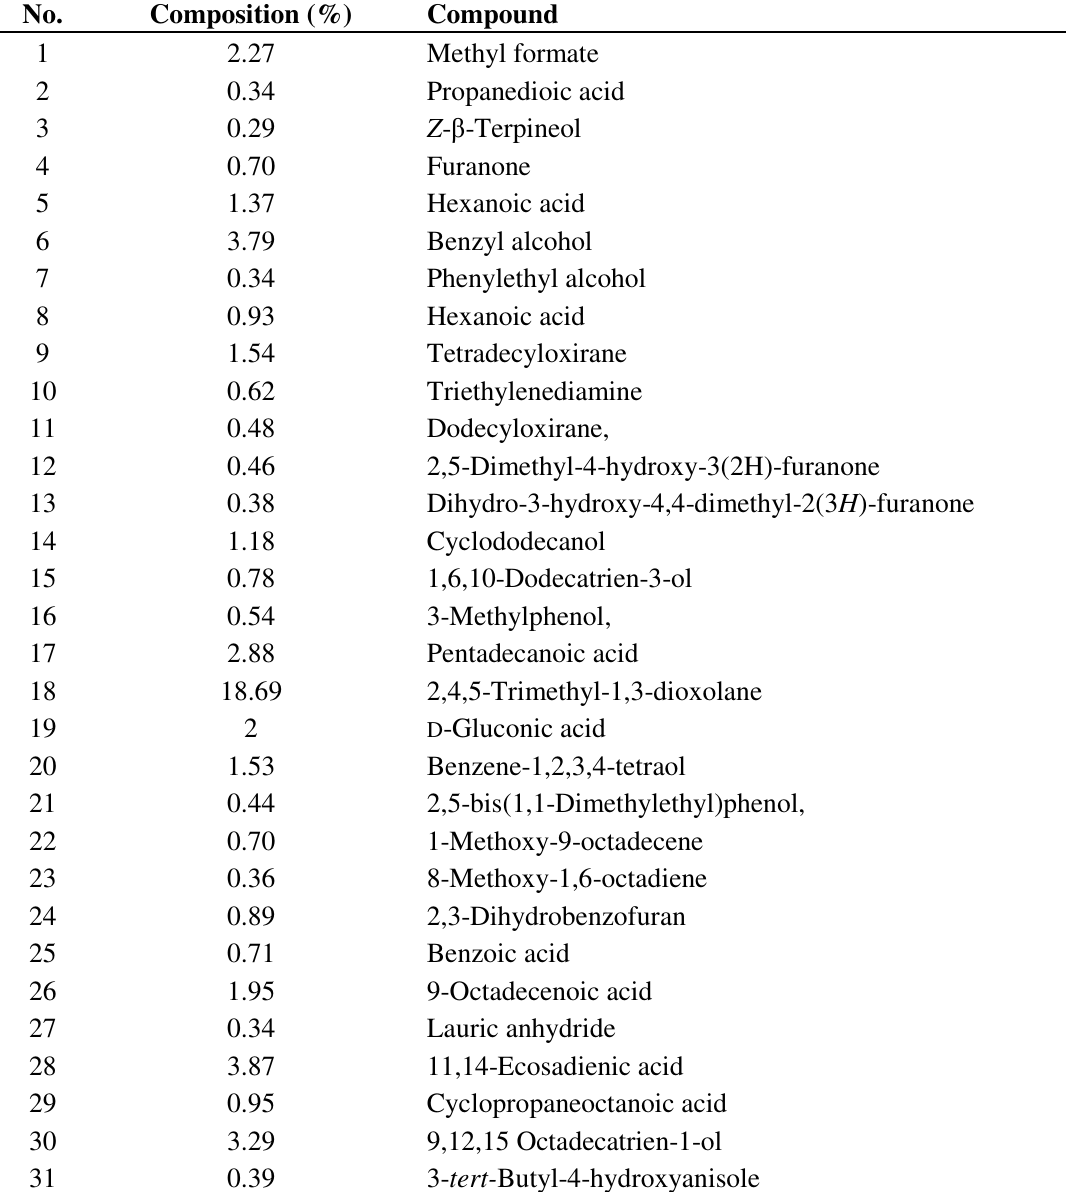
Table 9. Chemical composition of methanolic extraction of L. pumila var. lanceolata